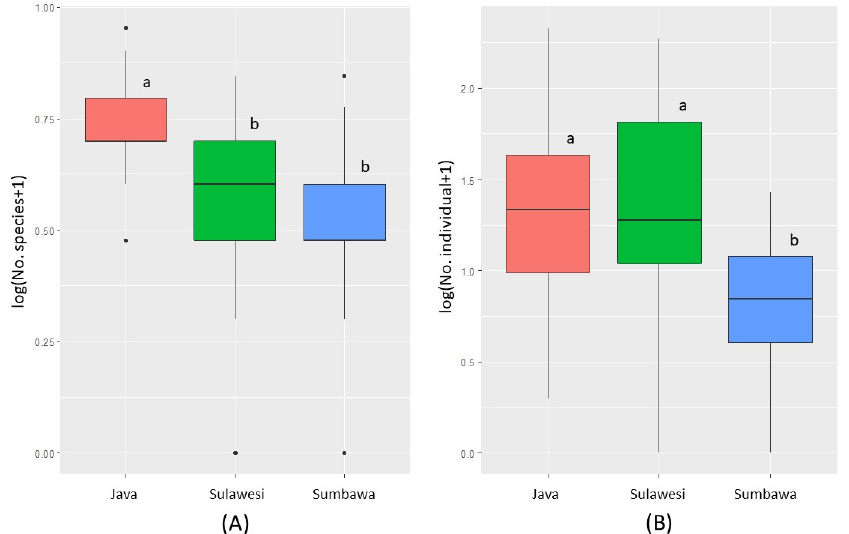
Figure 3. Species richness ( A ) and abundance ( B ) of ambrosia beetles between Java, Sumbawa, and Sulawesi islands. To achieve normal distribution, data of species richness and individual ambrosia beetle were transformed to log (x + 1). Above each box plot, different letters indicate significant differences (Tukey’s test, p < 0.05). Bars represent the interquartile range with the median value. Circles indicate outliers. Vertical solid lines indicate the minimum and maximum values.